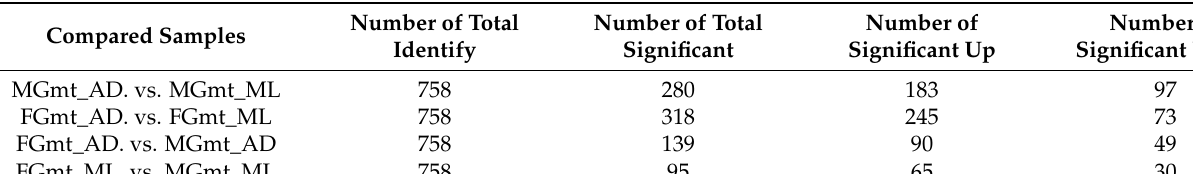
Table 1. Results of the analysis of differential metabolites.